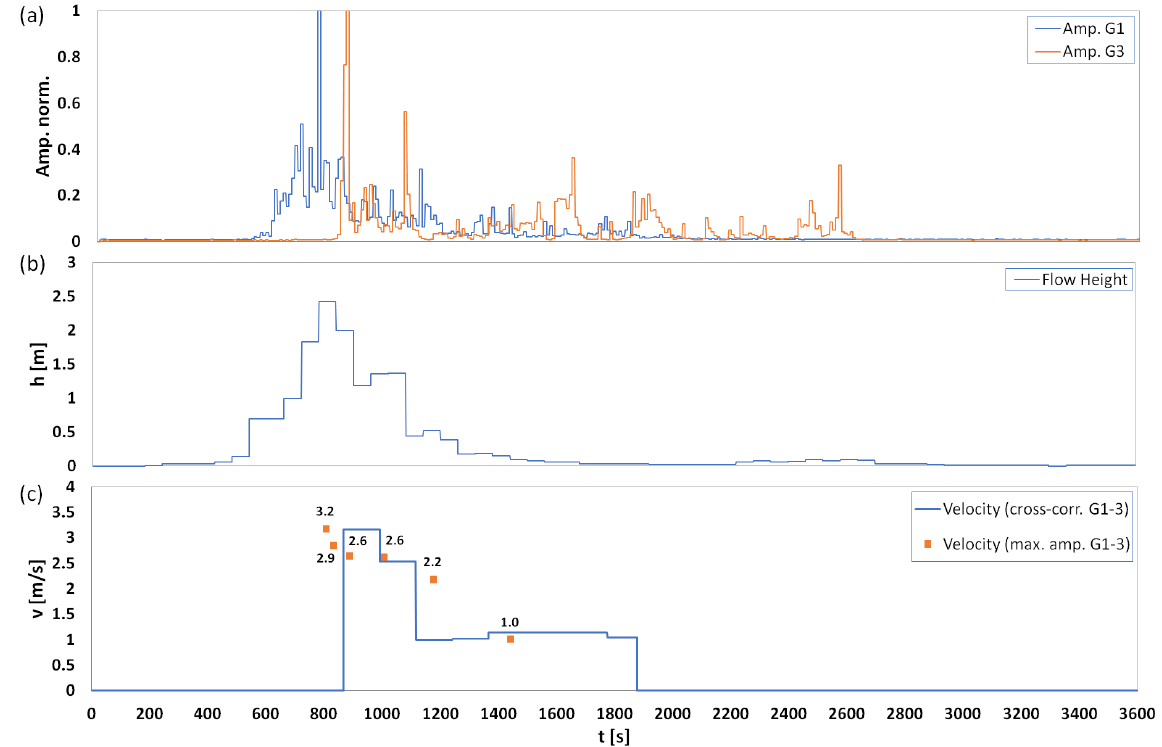
Figure 5. Debris flow at Cancia on 1 July 2020: (a) normalized amplitudes of the two geophones (G1, G3), (b) flow height, and (c) velocity estimation based on maximum values and cross-correlation.